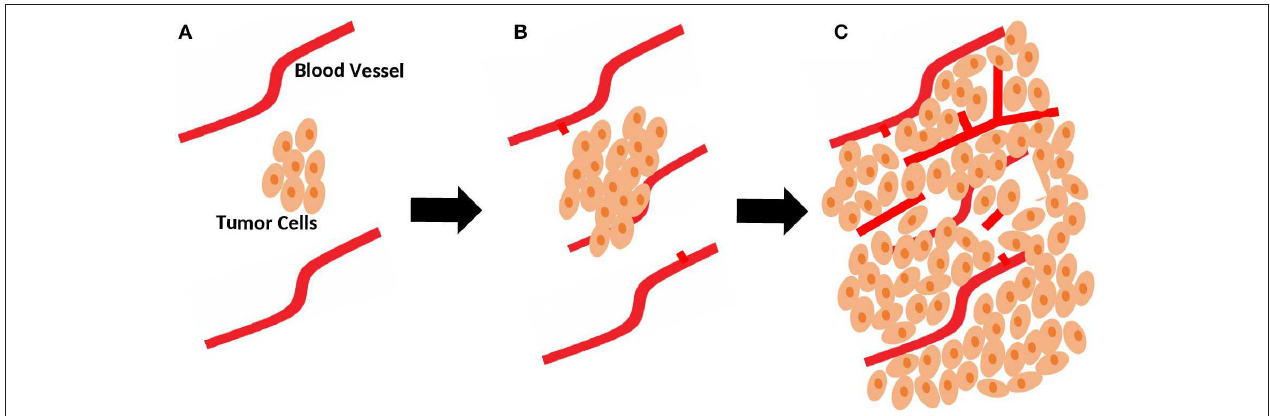
FIGURE 1 | Role of sprouting angiogenesis in tumor growth. (A) During early stages of development, tumor is still small in size and relies on local existing blood vessels for oxygen and nutrients supply. (B) As the tumor grows, sprouting of new vessels from local existing blood vessels occurs to fulfill the need for more oxygen and nutrients supplies. (C) Sprouting angiogenesis results in a more complex network of vasculature to provide adequate blood supply for the growing